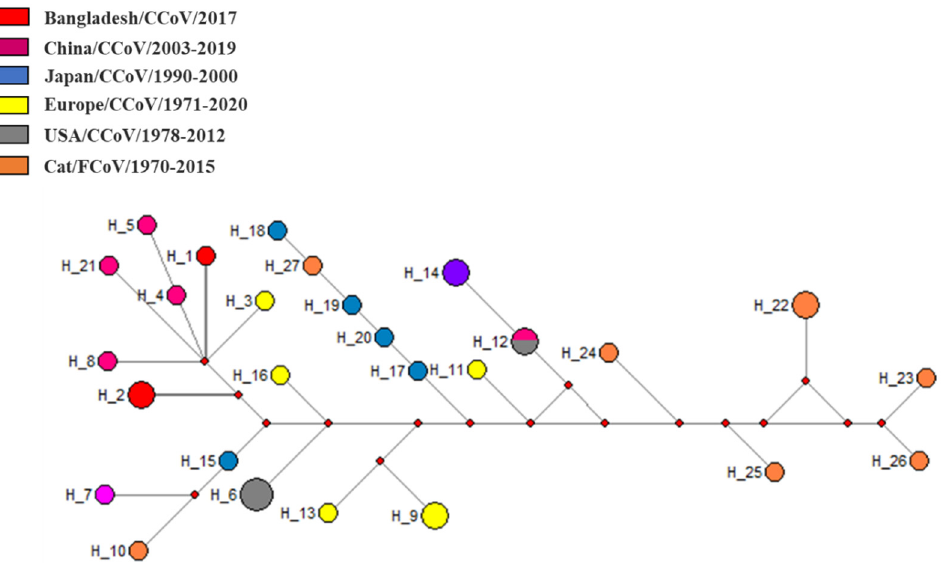
Figure 4. Median-joining phylogenetic network of Coronaviridae. The median-joining network was constructed from the partial RdRp sequences. Each unique sequence is represented by a circle sized relative to its frequency in the dataset. Isolates are colored according to the location. RdRp, RNA-dependent RNA polymerase.